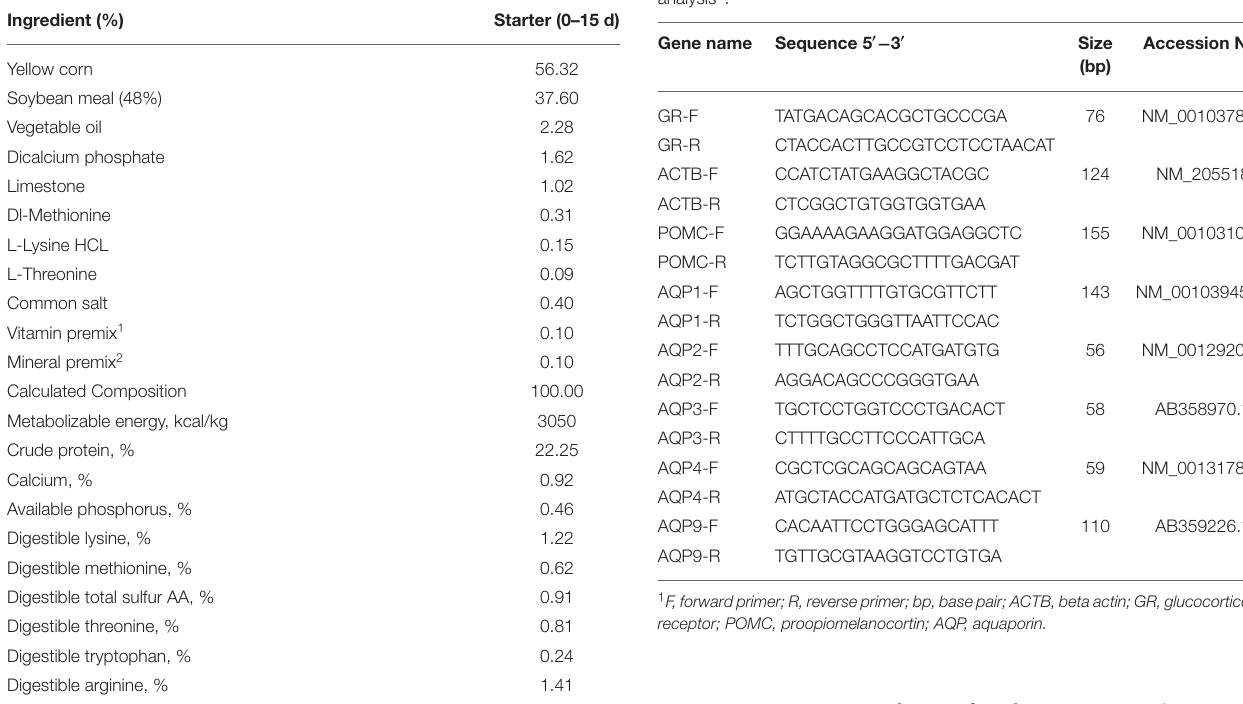
TABLE 1 | Feed ingredients and calculated composition of the basal diet. TABLE 2 | The primers sequence and information used for real-time PCR